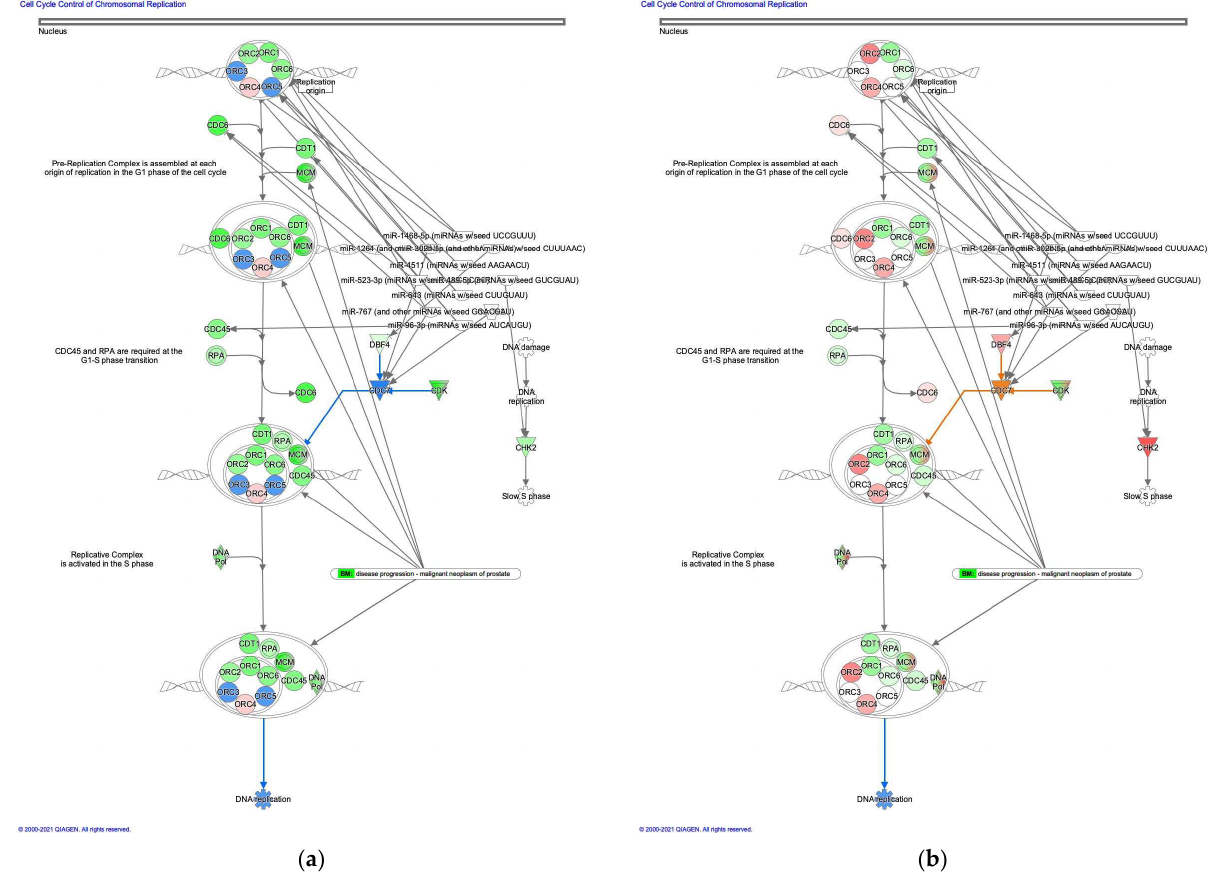
Figure 2. Cell cycle control of chromosomal replication was activated in intestinal-type GC. ( a ) Gene expression and pathway activity predictions in diffuse-type GC are shown. ( b ) Gene expression and pathway activity predictions in intestinal-type GC are shown. The genes whose expression was altered in diffuse- and intestinal-type GC are shown in pink (upregulated) or green (downregulated). Predicted activation and inhibition are shown in orange and blue, respectively.